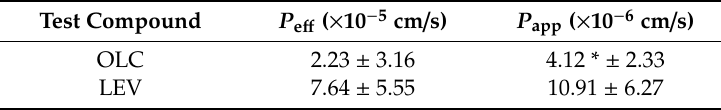
Table 2. Permeability coe ffi cients ( P e ff ) and apparent permeability coe ffi cients ( P app ) of oleocanthal and levofloxacin. Results are expressed as the mean ± SD of n = 4. Data are normalised to a 10-cm intestinal